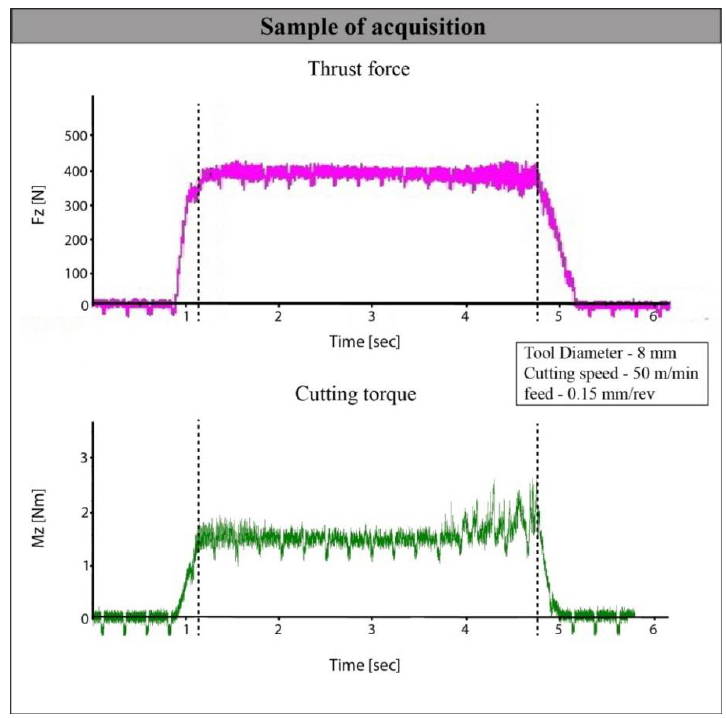
Figure 3. Experimental value (mean value) of thrust force and torque for a step drill with tool diameter of 8 mm, cutting speed of 50 m/min, and feed rate of 0.15 mm/rev.